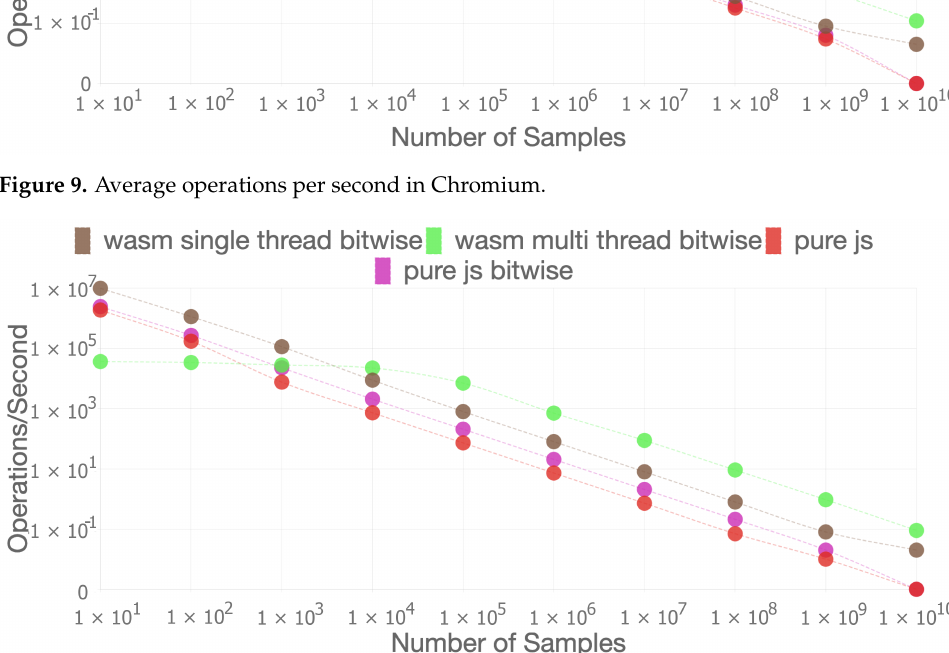
Figure 10. Average operations per second in